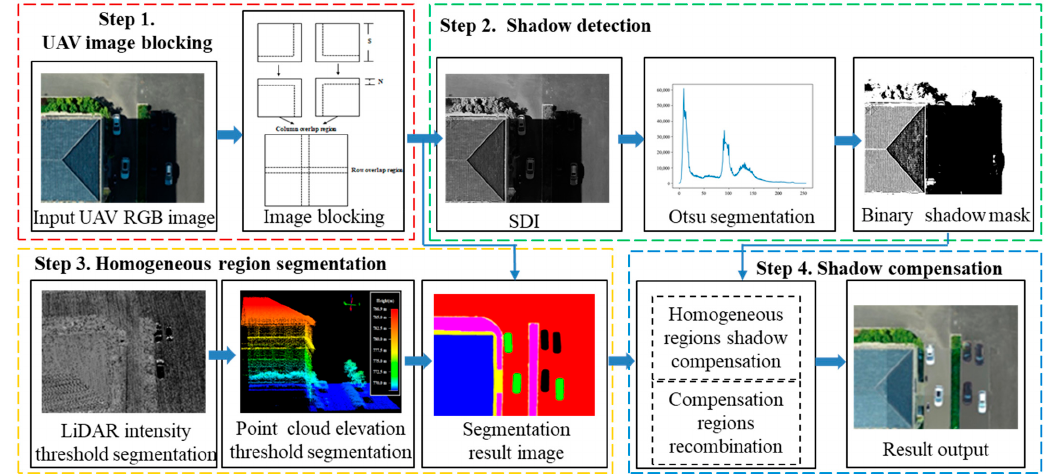
Figure 1. Flowchart of the proposed methods.